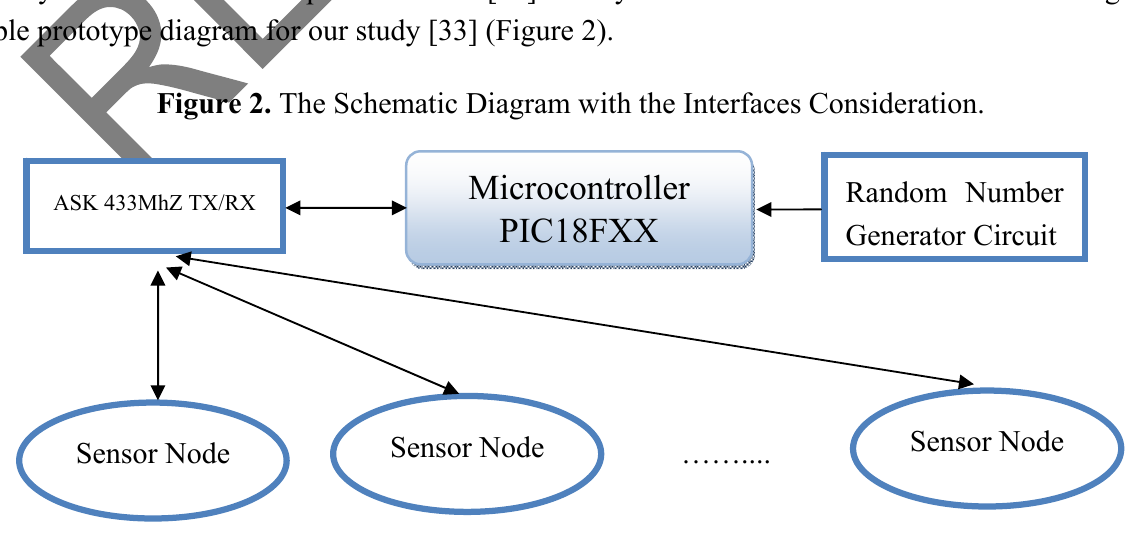
Figure 2. The Schematic Diagram with the Interfaces